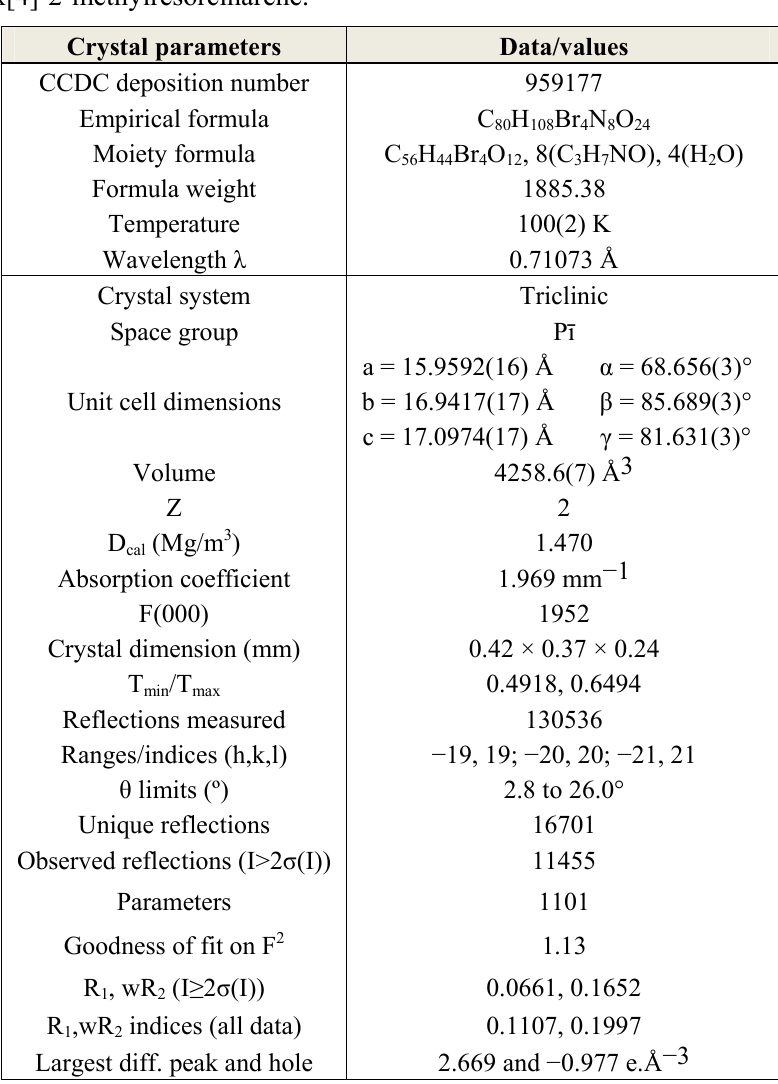
Table 5. Crystallographic data and structural refinement of